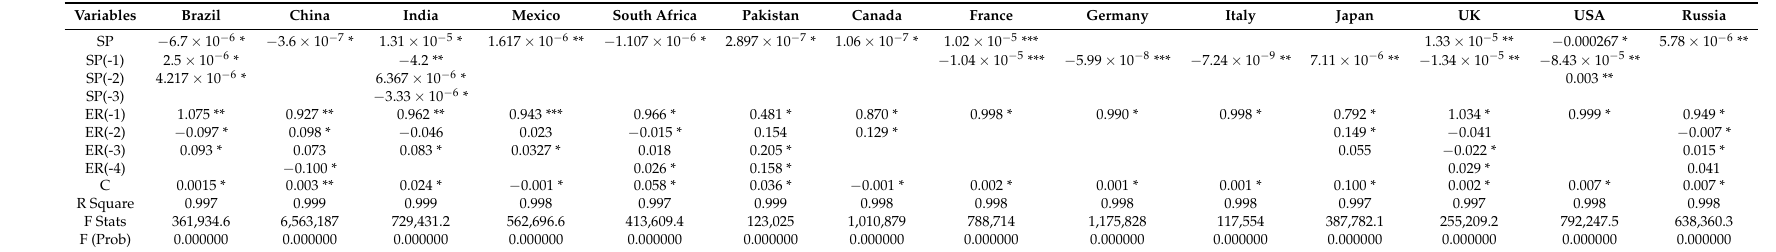
Table 4. ARDL dependent variable: exchange